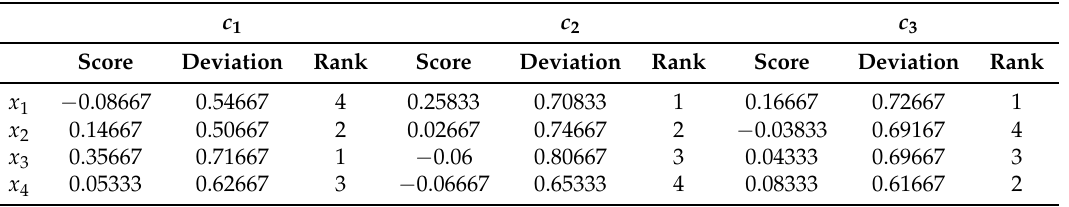
Table 8. Score and deviation values of DHFEs in matrix R .